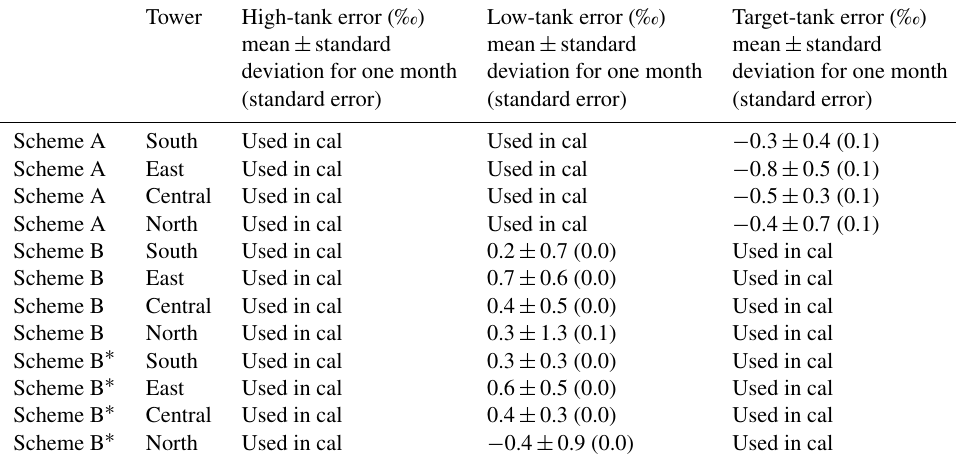
Table 3. Results for the four Marcellus towers using two possible calibration schemes. Tank errors are shown for using the high and low tank in the calibration (scheme A) and using the high and target tank in the calibration (scheme B). The third set of results are for scheme B, but following the change in field tank testing times on 3 December 2016. Results are from October 2016 for the south, east, and north towers but are from May 2016 for the central tower, as the analyzer was at the manufacturer for repairs during October 2016. Note that the daily means of the field tanks are used in the